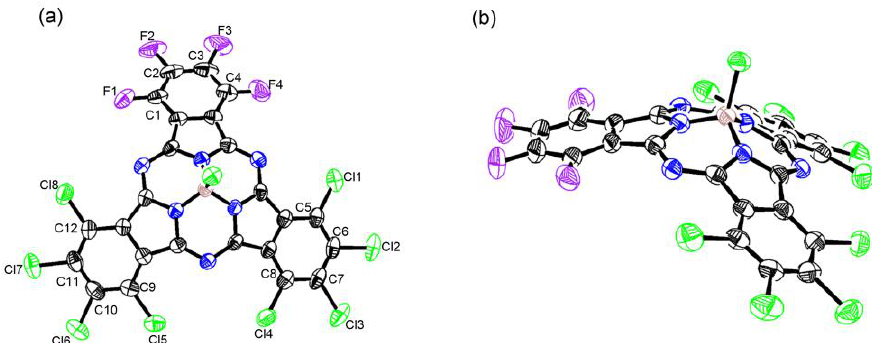
Figure 2. X-ray crystal structure of 6 : ( a ) top view and ( b ) side view. The thermal ellipsoids are scaled to the 50% probability level.